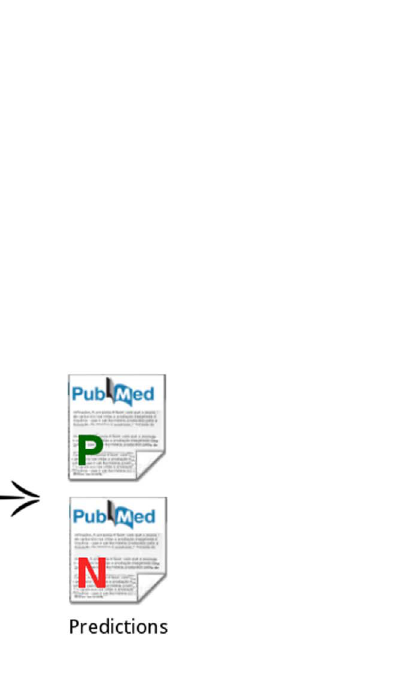
Fig. 1. System Workflow. mycoSORT Training and Testing